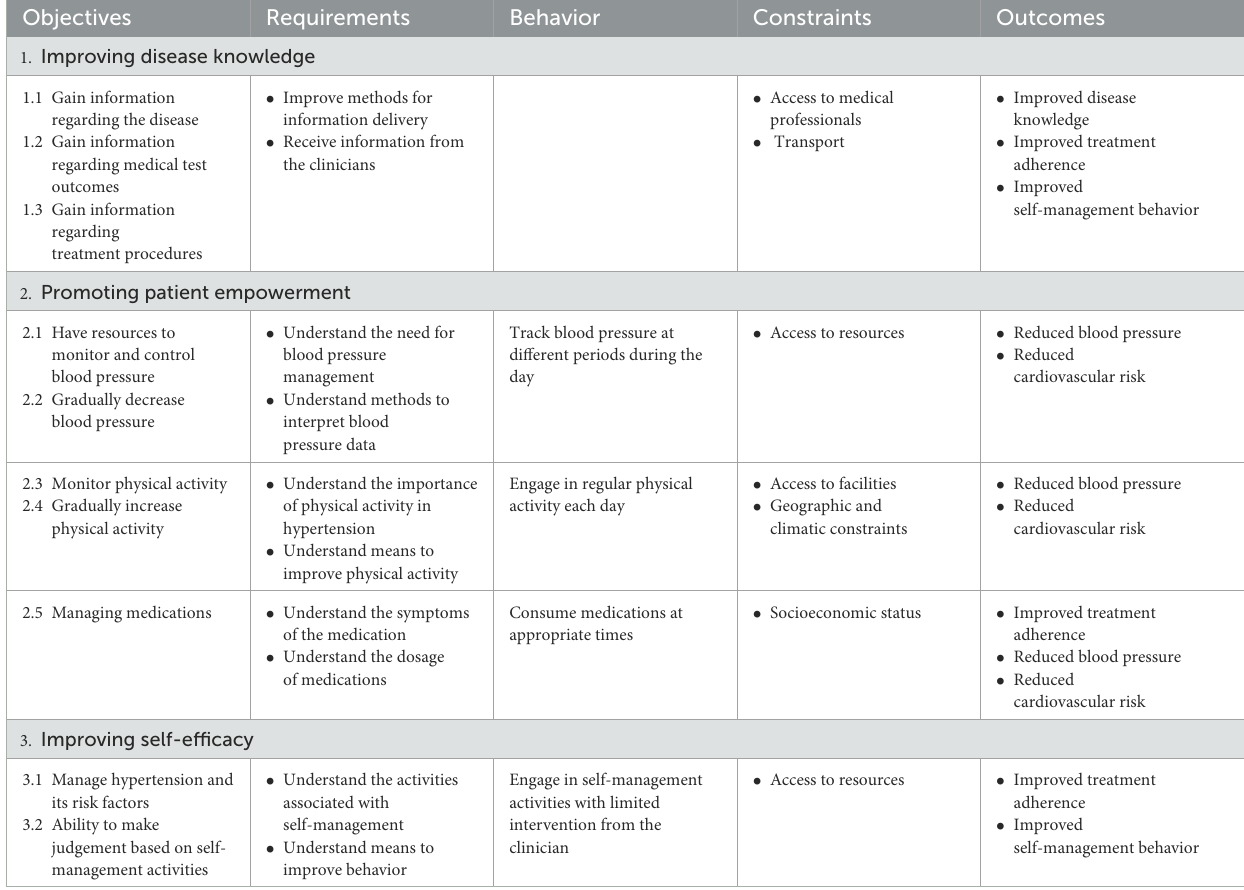
TABLE 2 Intervention outcomes, performance and change objectives matrix based on the need’s assessment in phase 1.